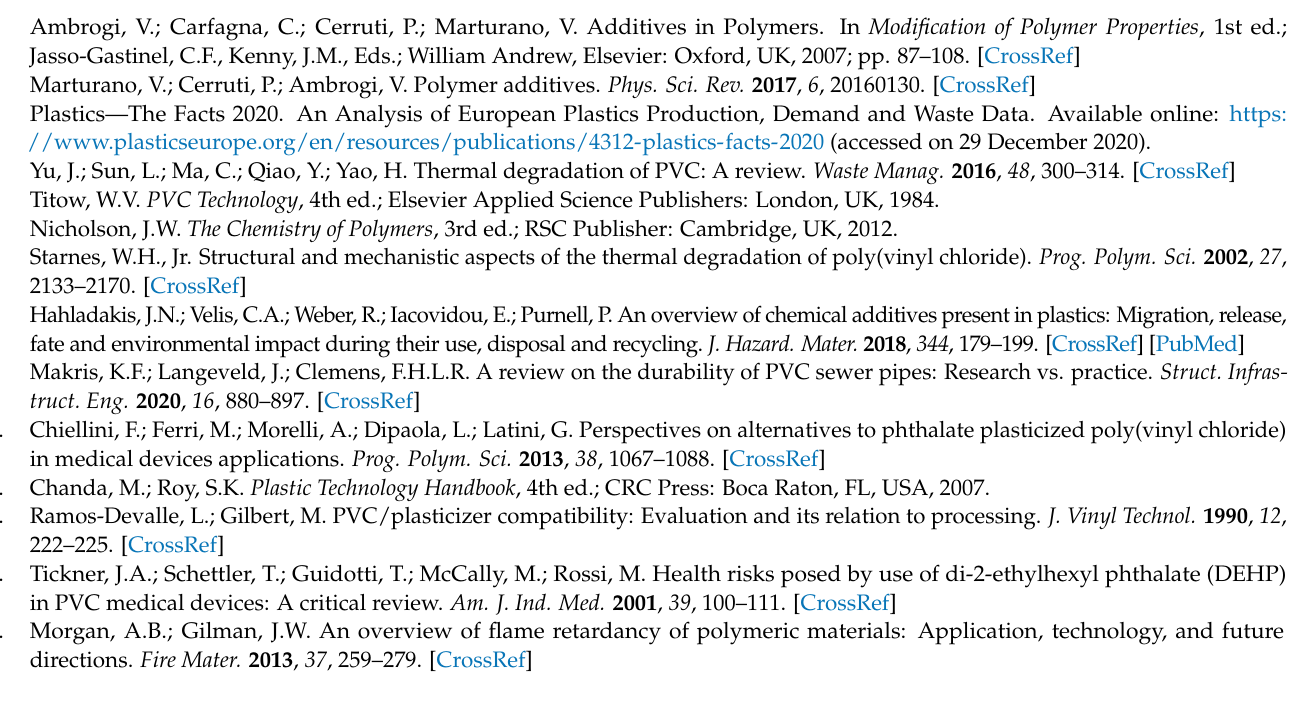
of 3 , Figure S4: 1 H NMR spectrum of 1 , Figure S5: 1 H NMR spectrum of 2 , Figure S6: 1 H NMR spectrum of 3 , Figure S7: 13 C NMR spectrum of 1 , Figure S8: 13 C NMR spectrum of 2 , Figure S9: 13 C NMR spectrum of 3 , Figure S10: EDX spectrum of PVC (blank) film before irradiation, Figure S11: EDX spectrum of PVC (blank) film after irradiation (300 h), Figure S12: EDX spectrum of PVC + 1 film after irradiation (300 h), Figure S13: EDX spectrum of PVC + 2 film after irradiation (300 h), Figure S14: EDX spectrum of PVC + 3 film after irradiation (300